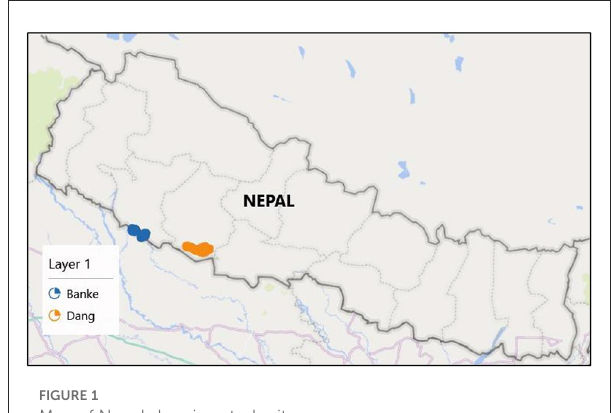
FIGURE1 Map of Nepal showing study sites.